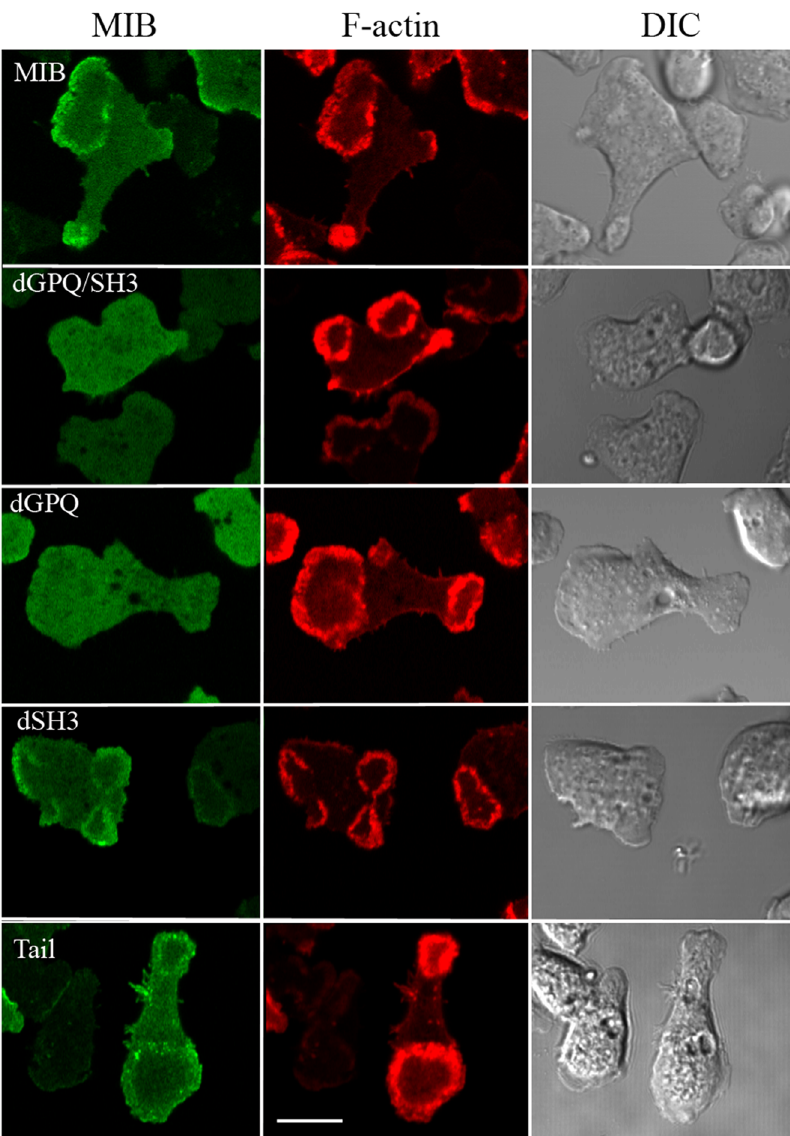
Figure 8. The GPQ-region is essential for MIB association with actin waves. myoB 2 -cells were co-transfected with mRFP-lifeact and with either GFP-MIB or GFP-tagged dGPQ/SH3, dGPQ, dSH3 or Tail as indicated in the figure. Cells were starved for 30 min after which 1 m M latrunculin was added and cell images were recorded. Mutants missing the GPQ region (dGPQ and dGPQ/SH3) did not associate with waves whereas dSH3 and Tail did. Bar is 10 m